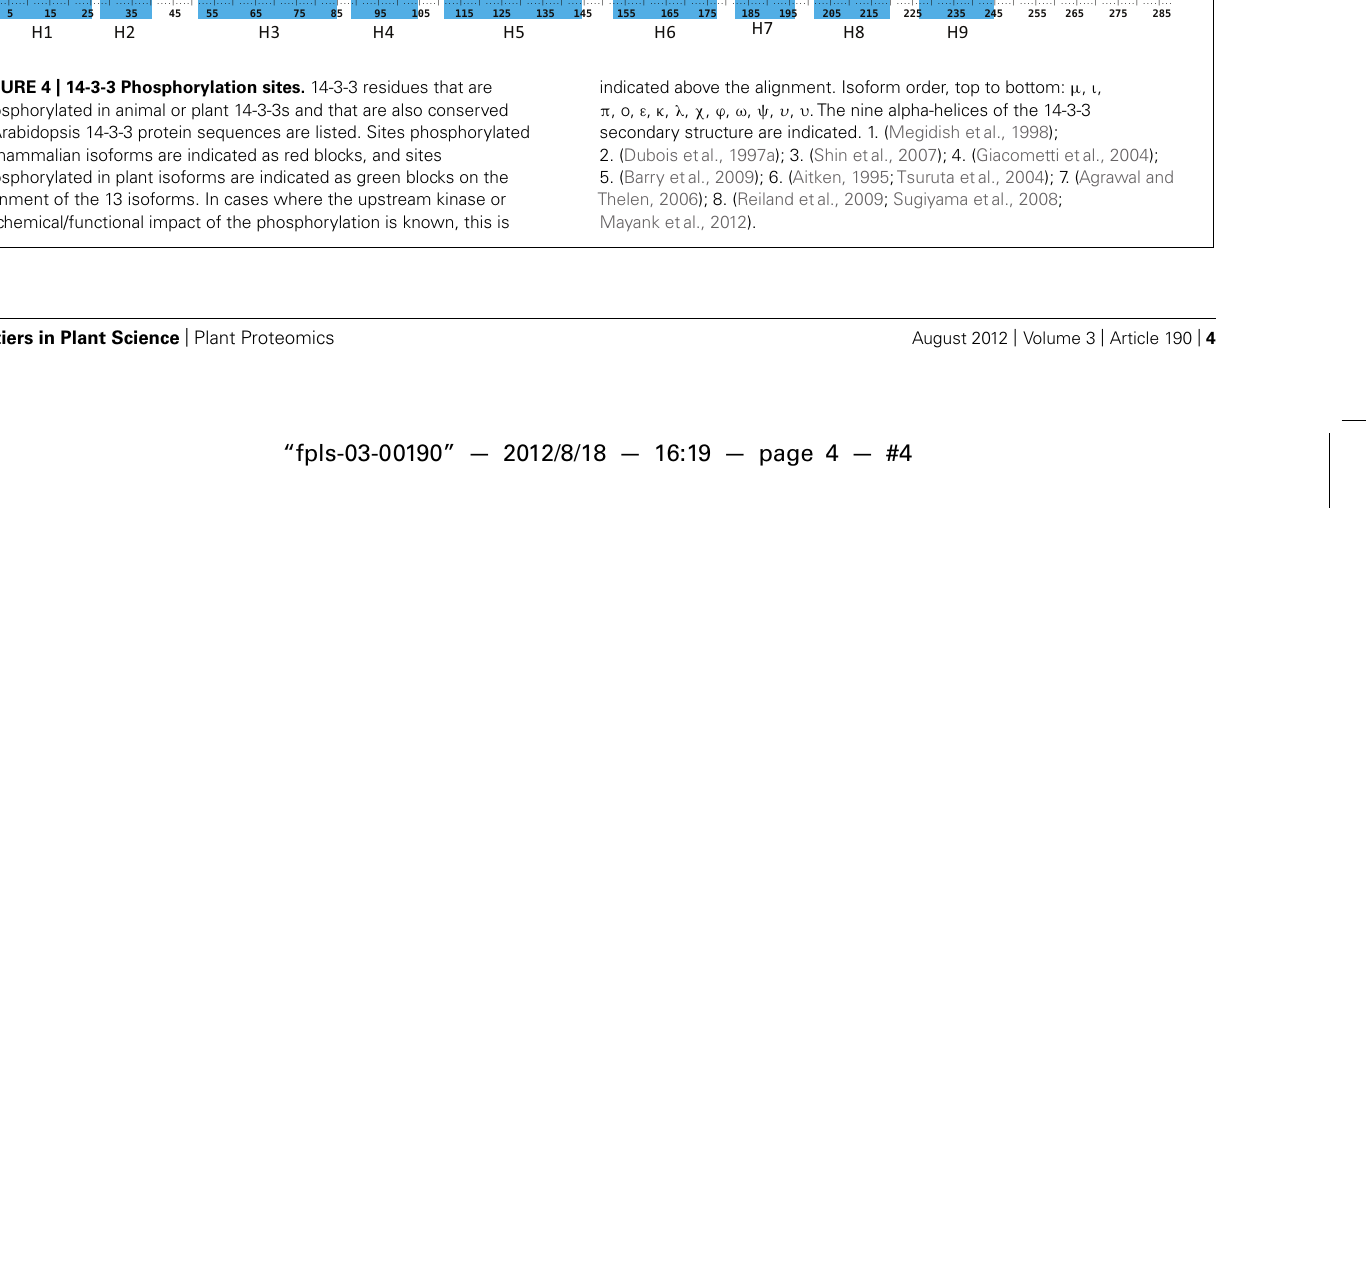
FIGURE 4 | 14-3-3 Phosphorylation sites. 14-3-3 residues that are phosphorylated in animal or plant 14-3-3s and that are also conserved in Arabidopsis 14-3-3 protein sequences are listed. Sites phosphorylated in mammalian isoforms are indicated as red blocks, and sites phosphorylated in plant isoforms are indicated as green blocks on the alignment of the 13 isoforms. In cases where the upstream kinase or biochemical/functional impact of the phosphorylation is known, this is